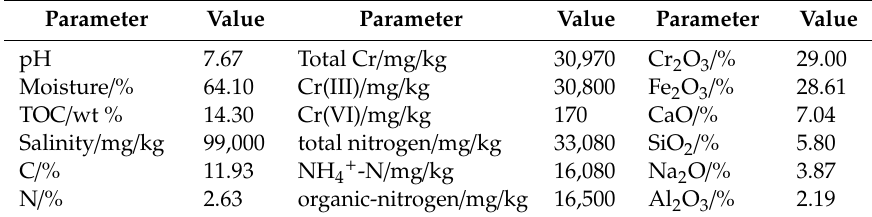
Table 1. Physicochemical characteristics of the tannery